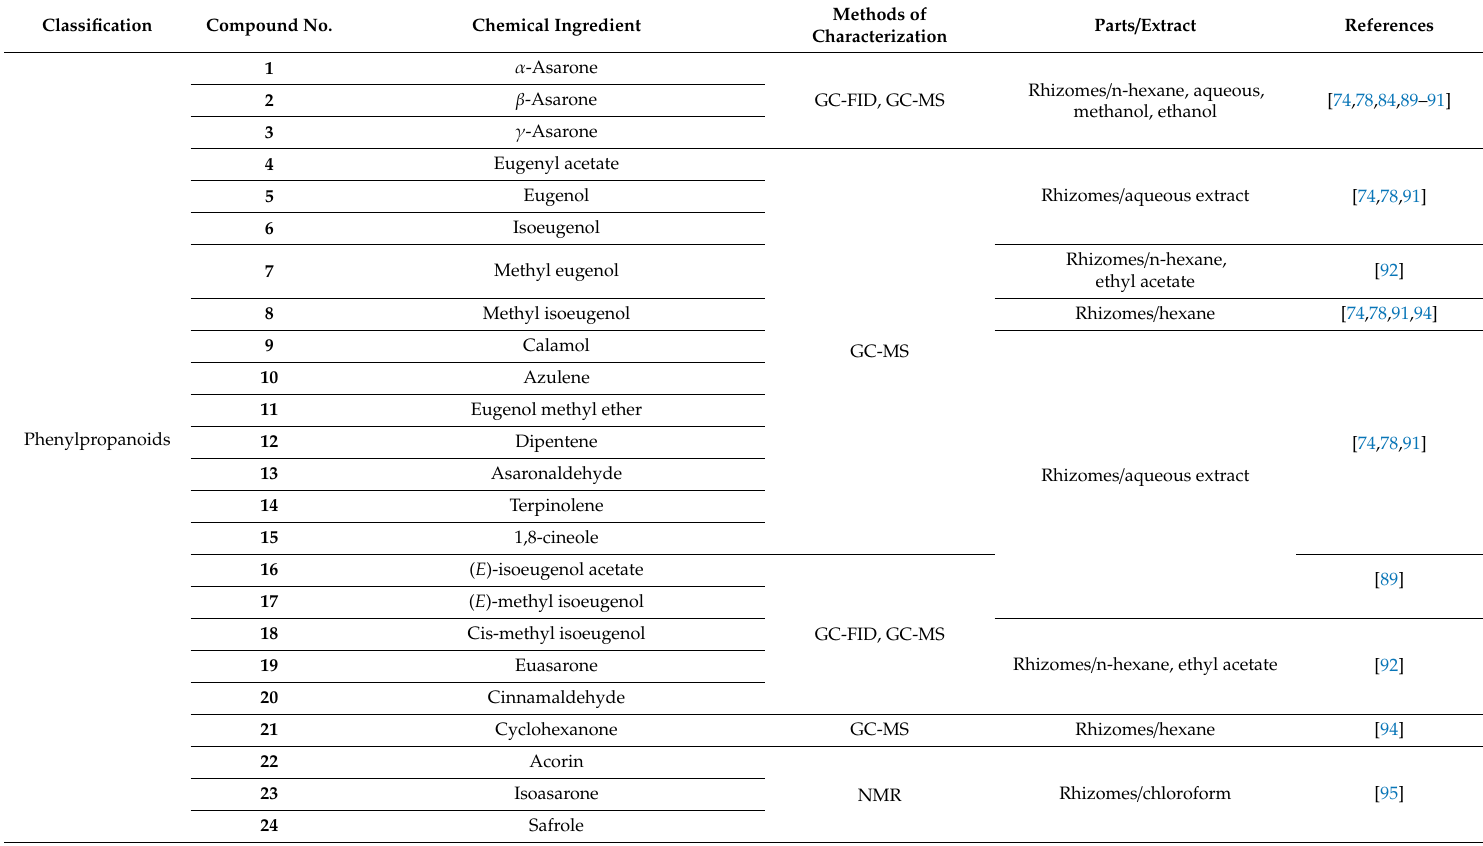
Table 3. Chemical compounds isolated from di ff erent botanical parts of A. calamus